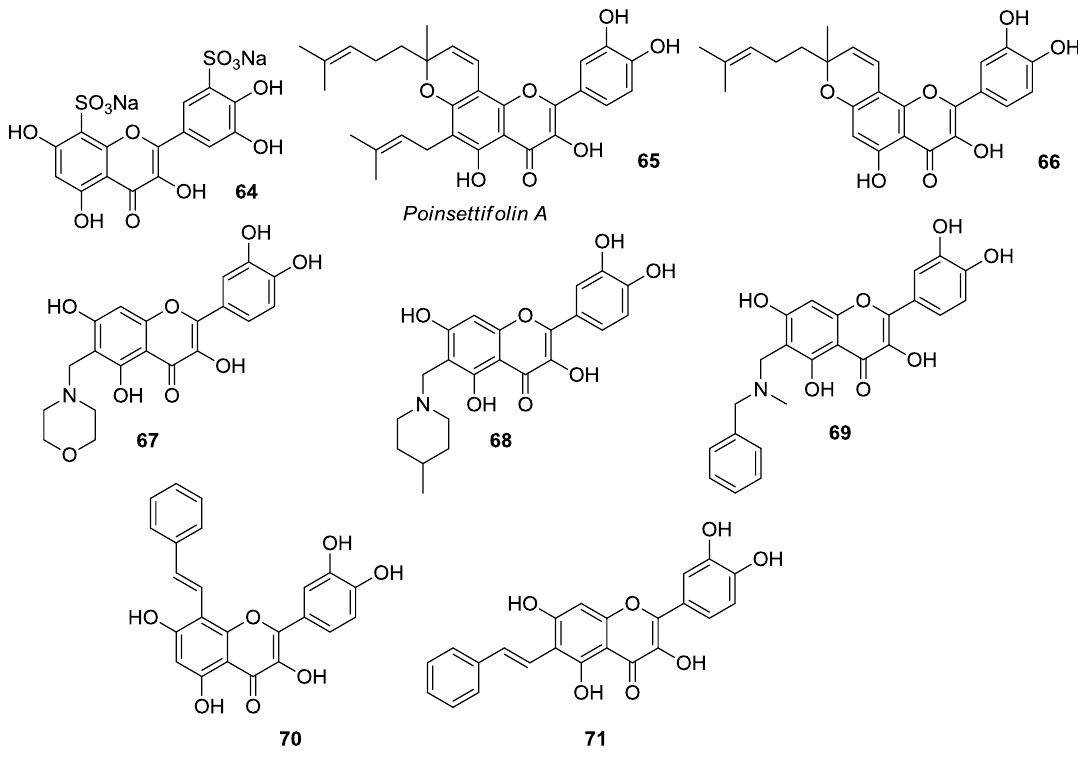
Figure 9. A- and B-ring functionalized quercetin derivatives 64 – 71 .